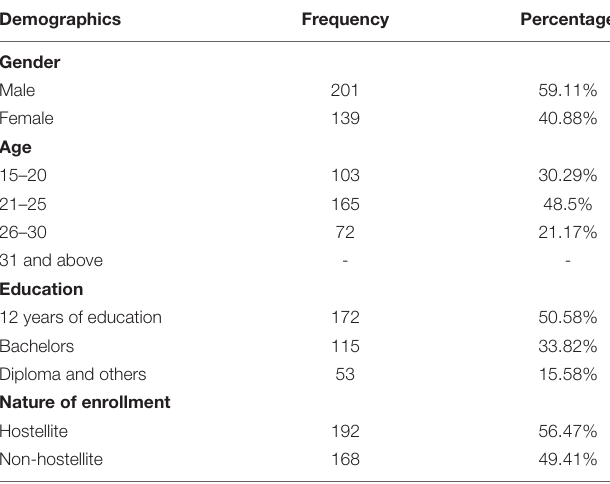
Heterotrait-monotrait tests are used along with the Fornell